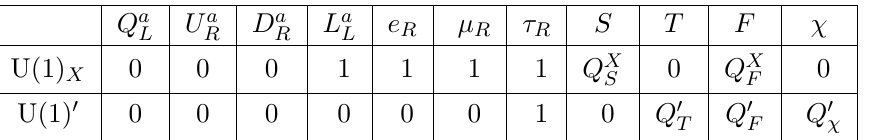
Table 4 . The U(1) X quantum number for SM matter contents with the generation index a = (1 ; 2 ; 3). The complex scalars S and T are introduced to break the U(1) X and U(1) 0 gauge symmetry, respectively. The Dirac fermion F that has charges of U(1), is introduced to generate kinetic mixing between the two U(1) gauge